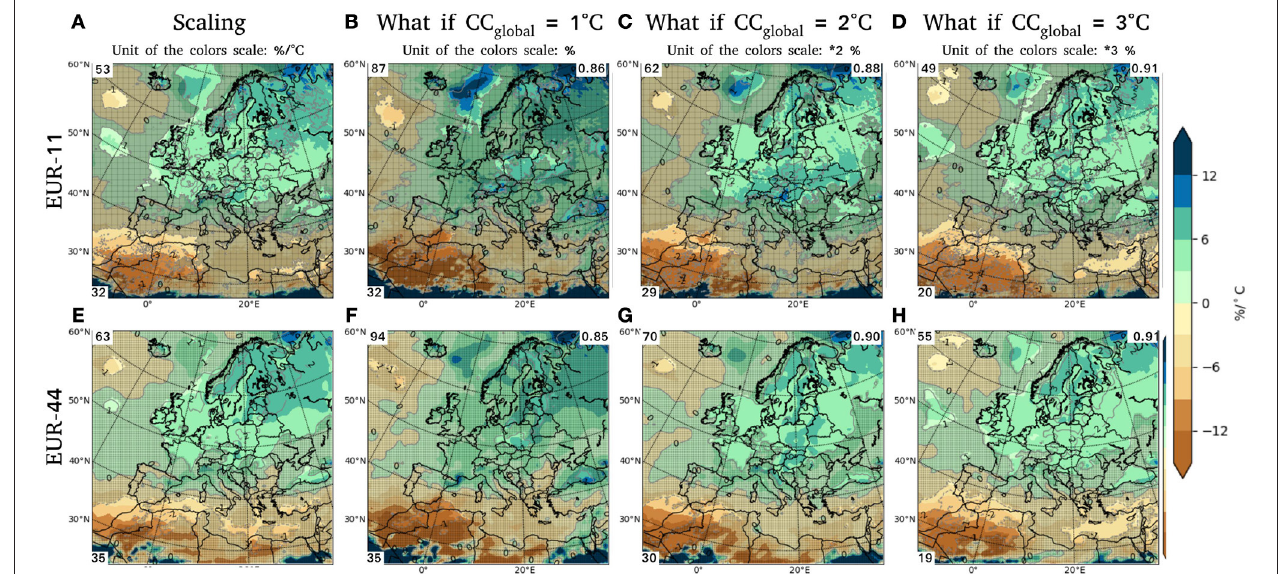
FIGURE 11 | DJF precipitation. Specifications and conventions as in Figure 8